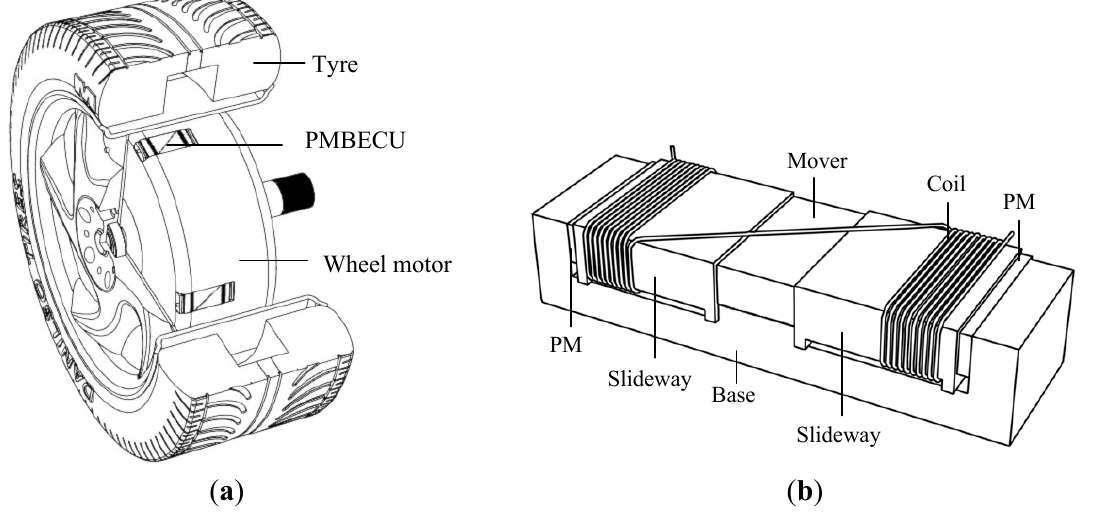
Figure 1. ( a ) Flexible connection of hub and motor; ( b ) Structure of the PMBECU.